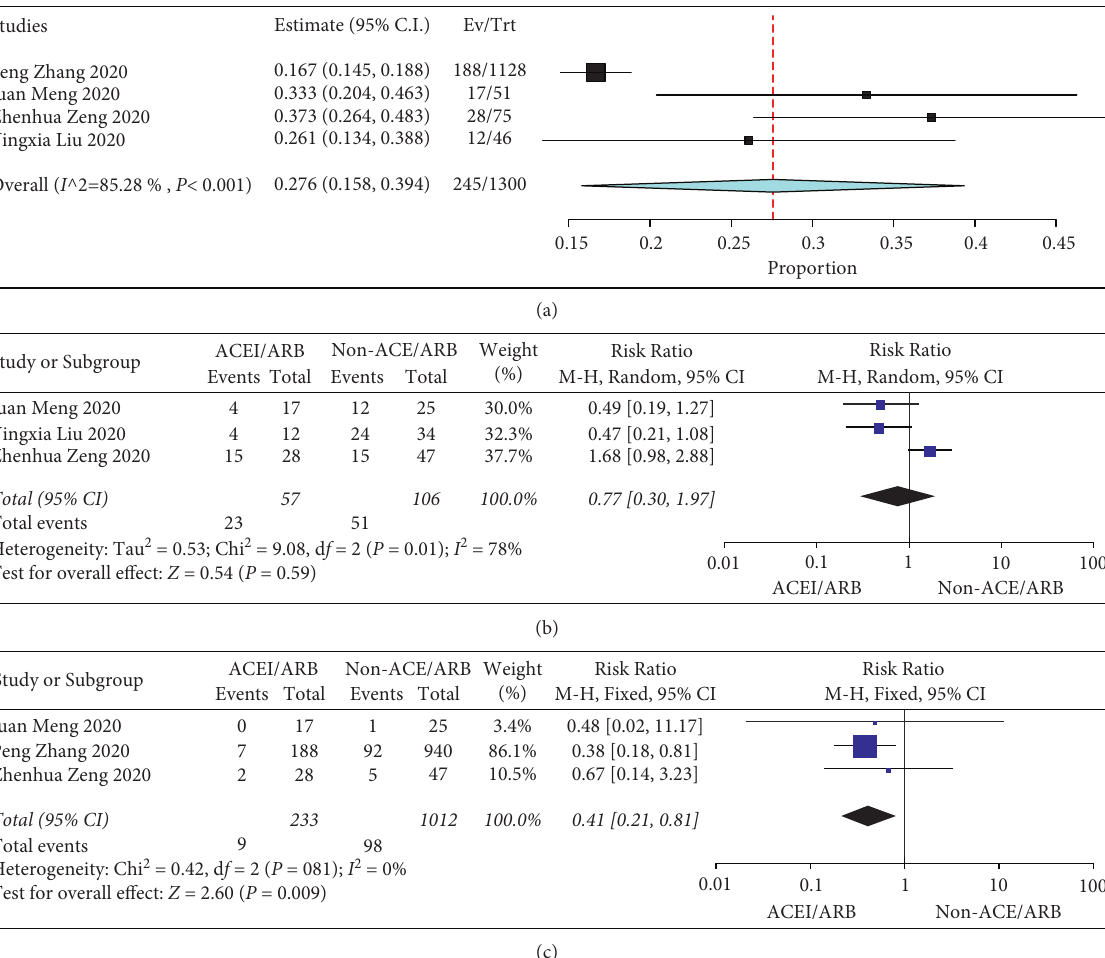
Figure 6: (a) Prevalence of usage of ACEIs/ARBs in COVID-19 patients with hypertension. (b) Comparison of mortality in ACEI/ARB and non-ACEI/ARB patients. (c) Comparison of the incidences of the severe/ICU rate in ACEI/ARB and non-ACEI/ARB